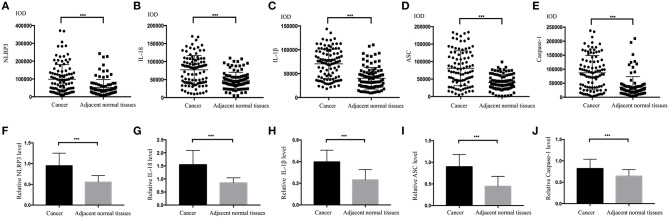
Comparisons of the IOD values for the NLRP3 inflammasome. (A) NLRP3; (B) IL-18; (C) ASC; (D) IL-1β; (E) Caspase-1 for the LSCC tissues and the adjacent normal tissues. Comparisons of the mRNA expression levels of the NLRP3 inflammasome for the LSCC tissues and the adjacent normal tissues using RT-qPCR (F)NLRP3; (G)IL-18; (H)ASC; (I) IL-1β; (J) Caspase-1. (all results, *P < 0.05, **P < 0.01, ***P < 0.001).